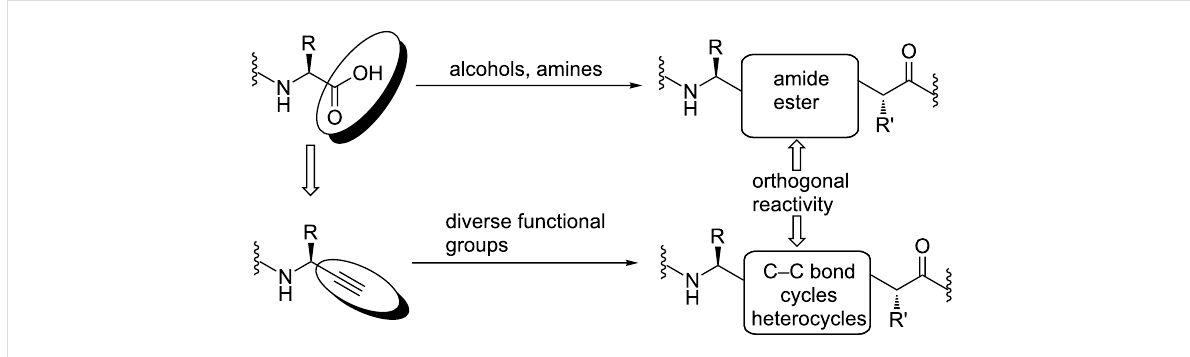
Figure 1: Concept of carboxylic acid or amide bond replacement on the basis of an alkyne moiety.